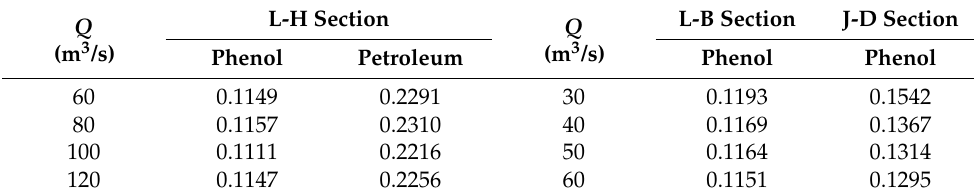
Table 5. Average degradation coefficient of each section.